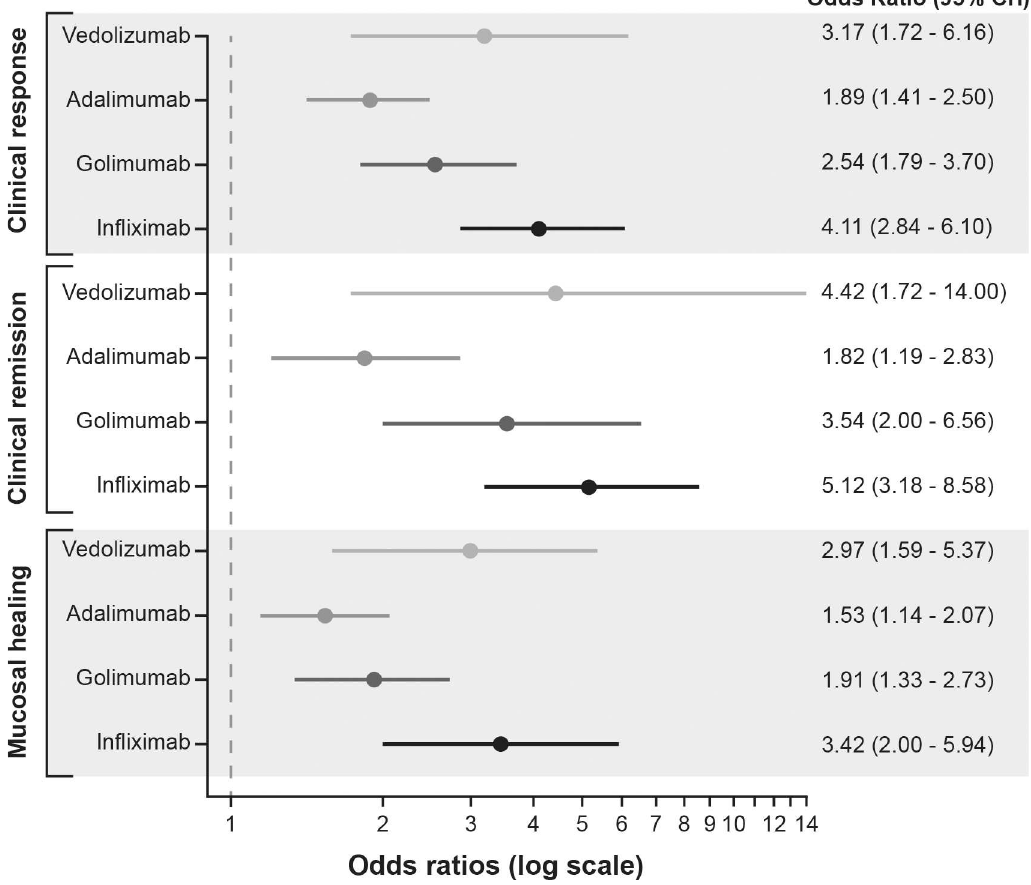
Fig 3. Forest plot of the odds ratios for biologics vs. placebo for anti-TNF therapy-na ï ve patients in induction studies. CrI, credibleinterval; TNF, tumour necrosis factor. Note: Adalimumabinductiondose: 160 mg followedby 80 mg; vedolizumab inductiondose: 300 mg; golimumabinductiondose: 200 mg subcutaneous at week 0, followedby 100 mg at week 2 and then 100 mg every 4 weeks; infliximab inductiondose: 5 mg/kg intravenously at week 0, followedby 5 mg/kg at 2 and 6